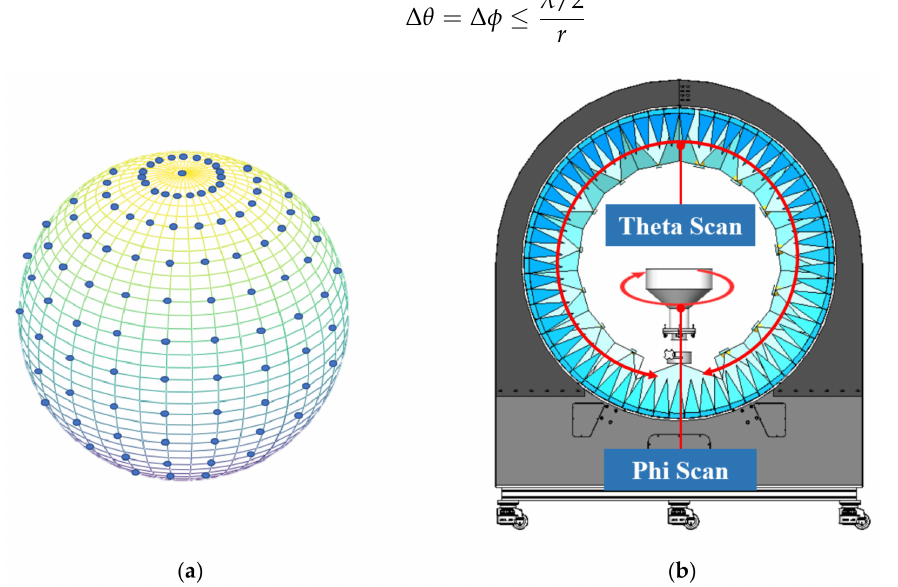
Figure 6. Sampling grid and geometry. ( a ) Equiangular sampling grid. ( b ) Geometry of MPAR